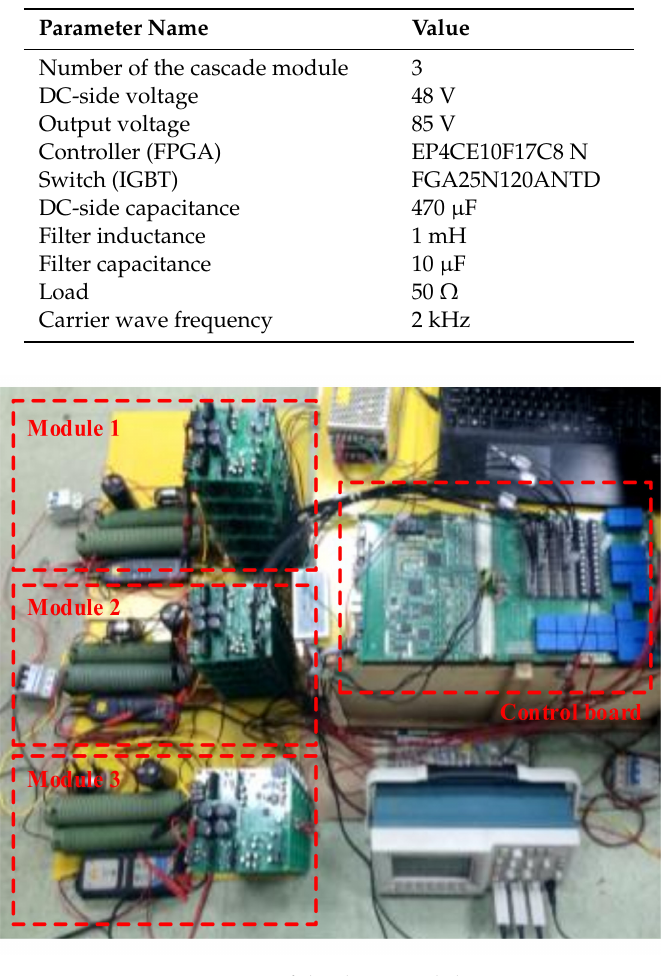
Figure 10. Prototype of the three-module 3LNPC-CC.